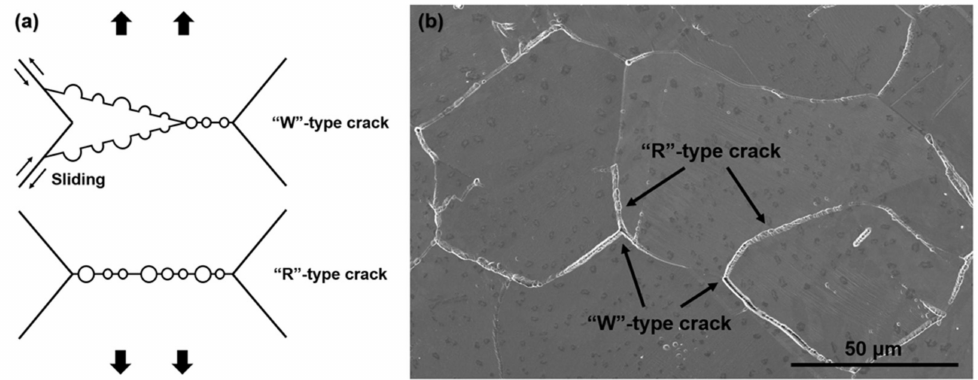
Figure 4. ( a ) Schematic illustrations and ( b ) actual morphologies of “W”-type and “R”-type cracks